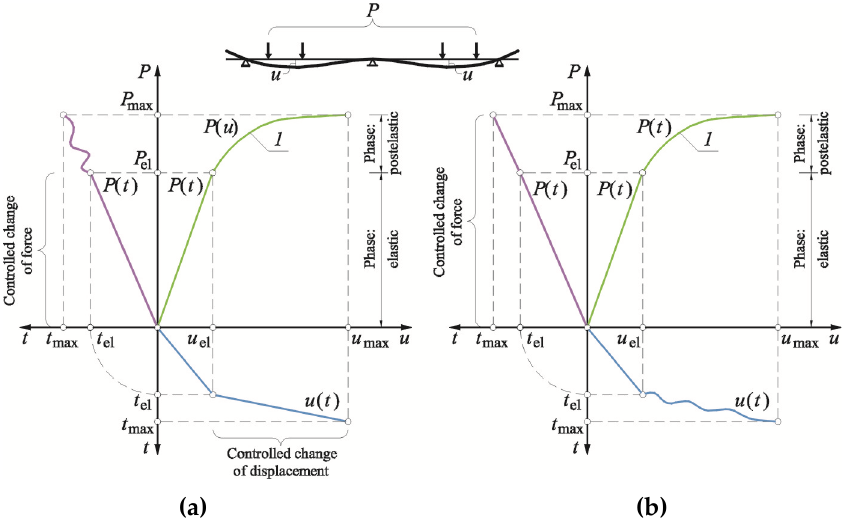
Figure 13. Changes in bending moments in the span and over the support in statically Figure 13. Changesinbendingmomentsinthespanandoverthesupportinstaticallynon-determinablebeam. Remote Sens. 2020 , 12 , x FOR PEER REVIEW 14 of 24 non-determinable beam.